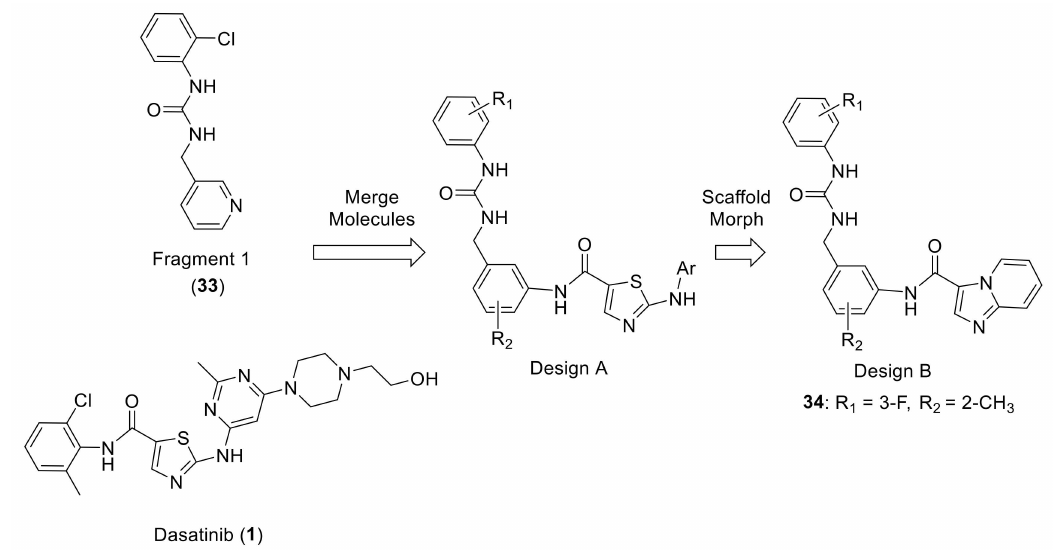
Figure 11. Schematic of the design process leading to discovery of compound 34 . Reprinted with permission from Ref.